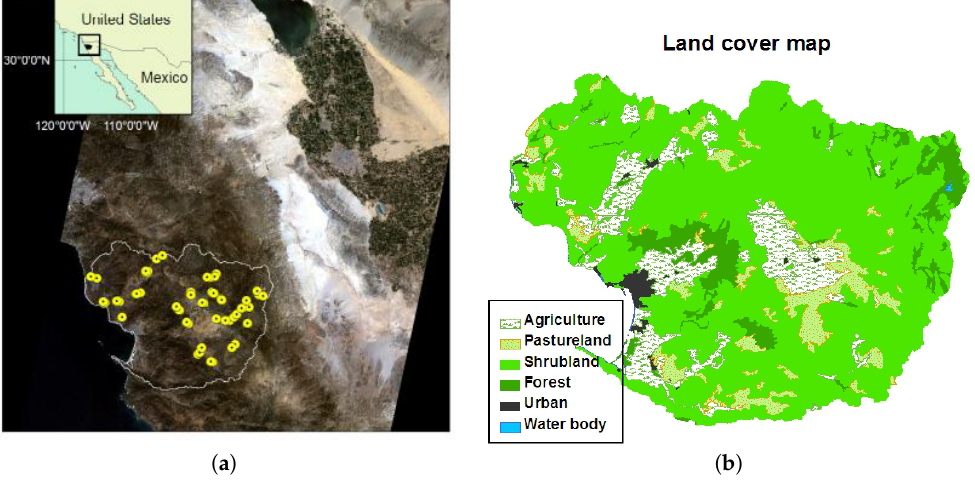
Figure 1. ( a ) The Todos los Santos watershed in Baja California, Mexico and the areas sampled by this study. ( b ) Land cover map for Todos Santos watershed [37]. The C factor value for each vegetation cover according to [8] have been